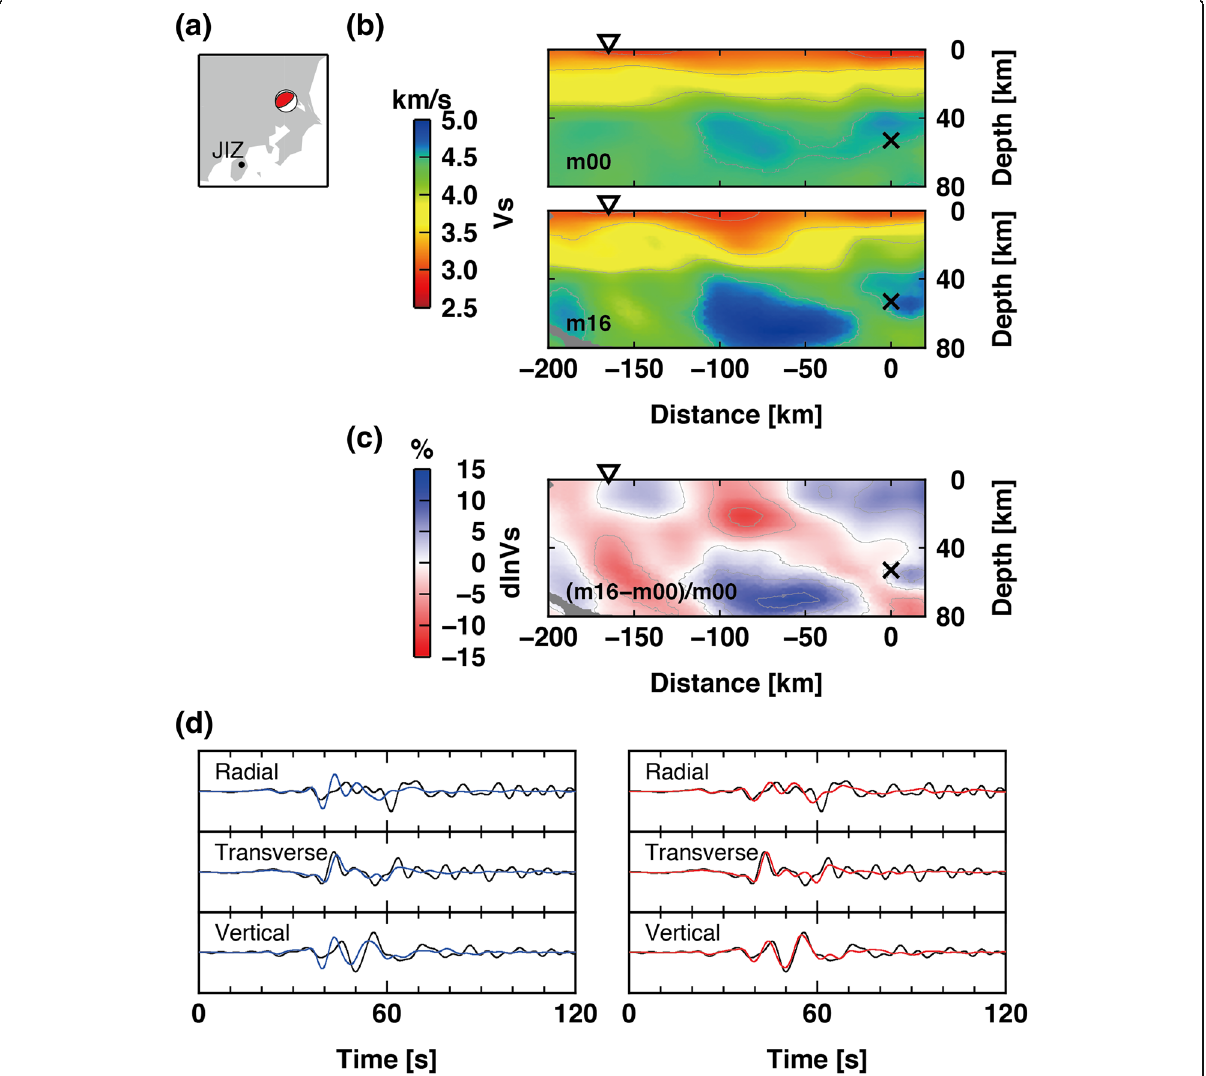
Fig. 8 Shear wave speed models and waveforms for the earthquake on the PHS (June 2, 2007; M W 4.5). a Source and receiver. b Vertical cross section of V s for m 00 and m 16 . c Vertical cross section of the difference between the V s values for m 00 and m 16 . d Waveform comparisons. The gray areas in ( b ) and ( c ) indicate areas of low data coverage. The crosses and inverted triangles in ( b ) and ( c ) show the location of the earthquake and station in ( a ), respectively. The black, blue, and red lines in ( d ) indicate the observed, m 00 , and m 16 waveforms,